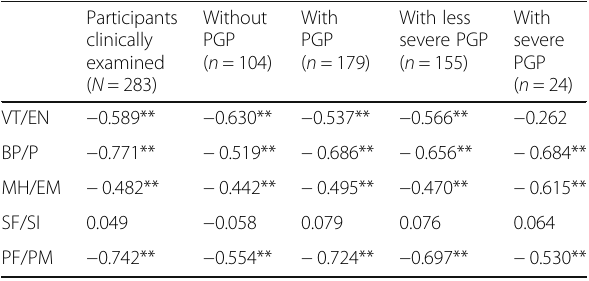
Table 4 Correlations of corresponding dimensions of SF-36 and